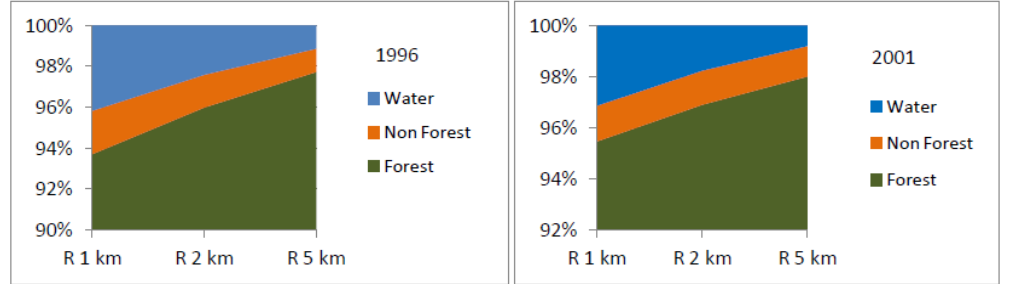
Figure 8. Forest, non-forest and water land-cover change dynamic of 1 km, 2 km,